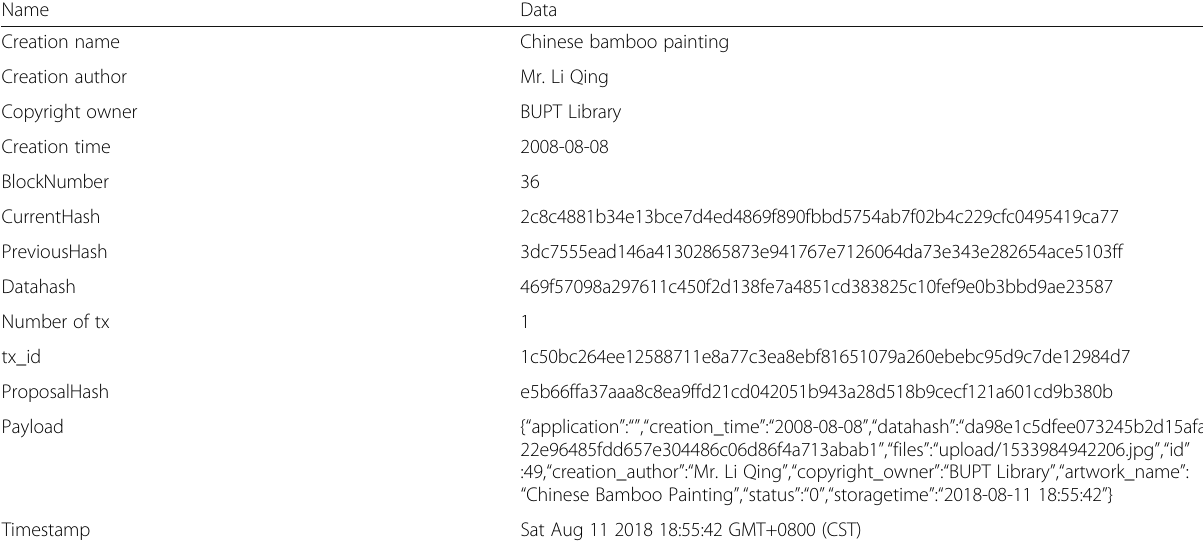
Table 5 Artwork DRM blockchain data